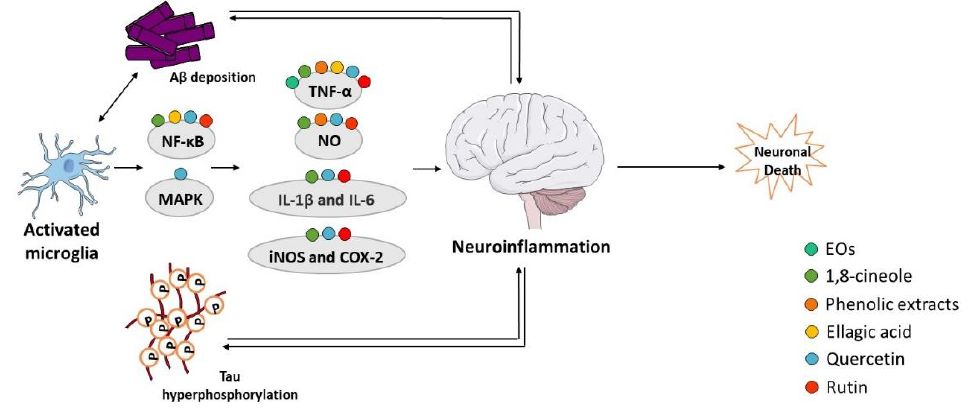
Figure 5. Effect of compounds obtained from E. globulus leaves on neuroinflammation in AD. A vicious circle between A β and tau accumulation in the brain, microglia activation, and release of pro-inflammatory cytokines culminates in neuronal death in AD.